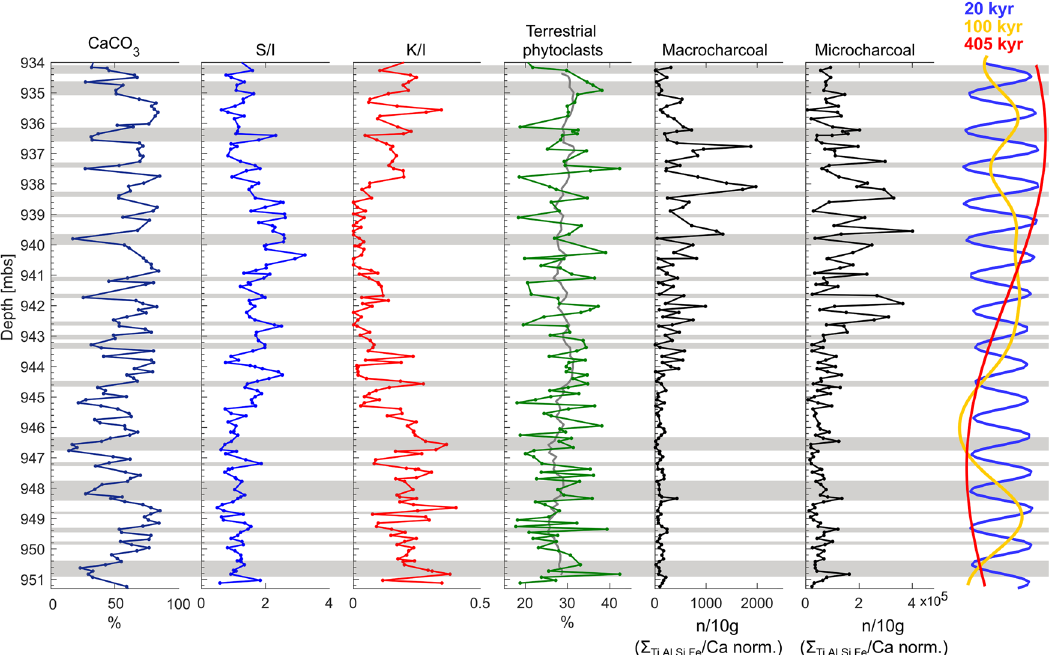
Fig. 2 Short and long cyclic alternations are observed in the proxy records during the studied interval. A major shift at ~944 mbs is observed in the calcium-carbonate, smectite/illite, kaolinite/illite, percentage of terrestrial organic particles and the macro- and micro-charcoal abundance. The moving average (~1 m) of the percentage terrestrial phytoclasts is displayed in the light grey curve. TOC-enhanced lithological beds are marked by a light grey bar, with the carbonate-rich layers displayed in white. In the part of the record where there is evidence for strong seasonality (i.e. S/I-rich) the expression of precession is visible in large macrocharcoal peaks, which are coeval with carbonate-rich beds. We hypothesize that this interval (~934 – 944 mbs) lies within an increasing phase of a long eccentricity cycle. The orbital fi lters are derived from the elemental Ca record of Ruhl et al. 43 spanning the Margaritatus Zone of the Pliensbachian of